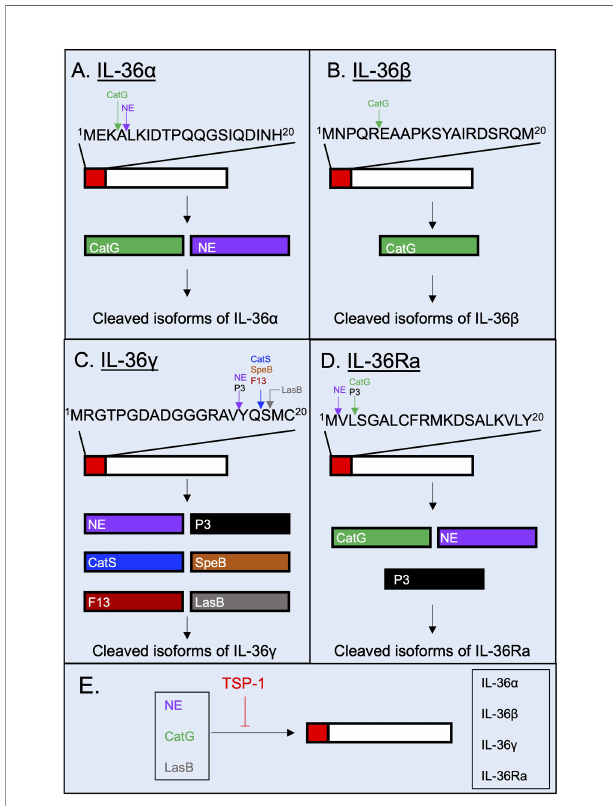
FIGURE 3 | Post-translational processing of human IL-36 cytokines by extracellular proteases. Human IL-36 cytokines are selectively cleaved and potentially activated by proteases. (A) IL-36 a is cleaved extracellularly by neutrophil proteases Cathepsin G (CatG) and Neutrophil Elastase (NE). (B) IL-36 b has been described to be N-terminally processed by CatG. (C) IL-36 g is selectively cleaved by Proteinase-3 (P3), NE, Cathepsin S (CatS), the Streptococcus pyogenes -derived protease SpeB, the Aspergillus fumigatus -derived protease F13 and the Pseudomonas aeruginosa -derived protease LasB. (D) IL-36Ra is cleaved and potentially activated by NE, CatG and P3. (E) The proteolytic cleavage of IL-36 cytokines can be regulated by the host glycoprotein thrombospondin-1, which has been shown to possess inhibitory properties against the host proteases NE and CatG, and against the bacterial protease